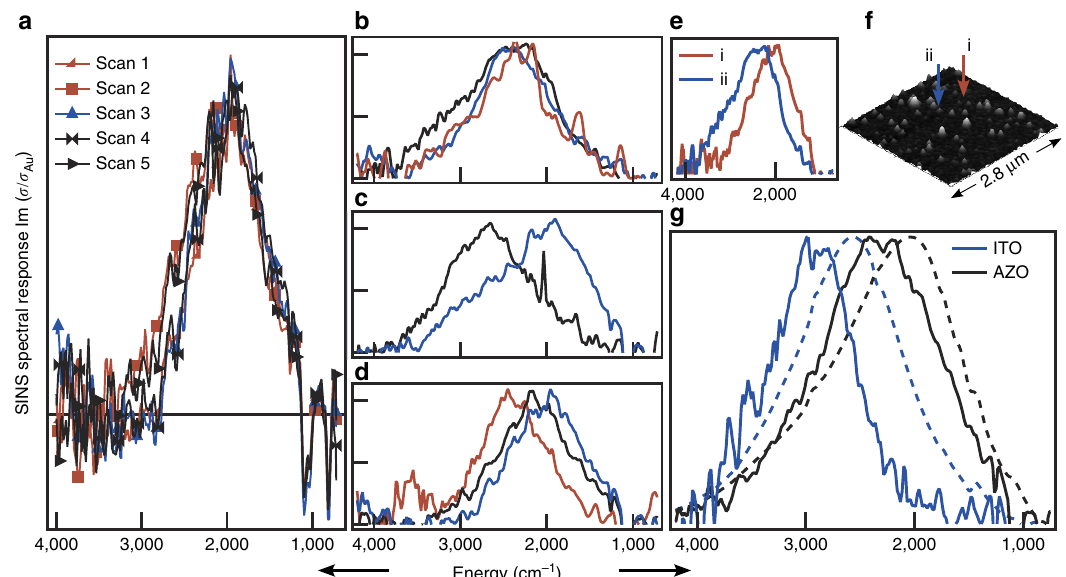
Figure 2 | Heterogeneity observed by single nanocrystal spectroscopy of AZO. ( a ) Repeated scans of an individual nanocrystal reproduce the same spectrum. A horizontal line at zero is included. Variations among nanocrystals were observed in ( b ) linewidth, ( c ) peak asymmetry and ( d ) peak energy. The eight spectra shown in b – d are each an average of several scans of an individual nanocrystal. Single nanocrystal spectra ( e ) are correlated with topographic information from AFM ( f ). ( g ) The sums of all collected single nanocrystal spectra (solid lines) form pseudo-ensembles for comparison to ensemble spectra measured by conventional transmission FTIR of thin films on KBr substrates (dashed lines) for both AZO and